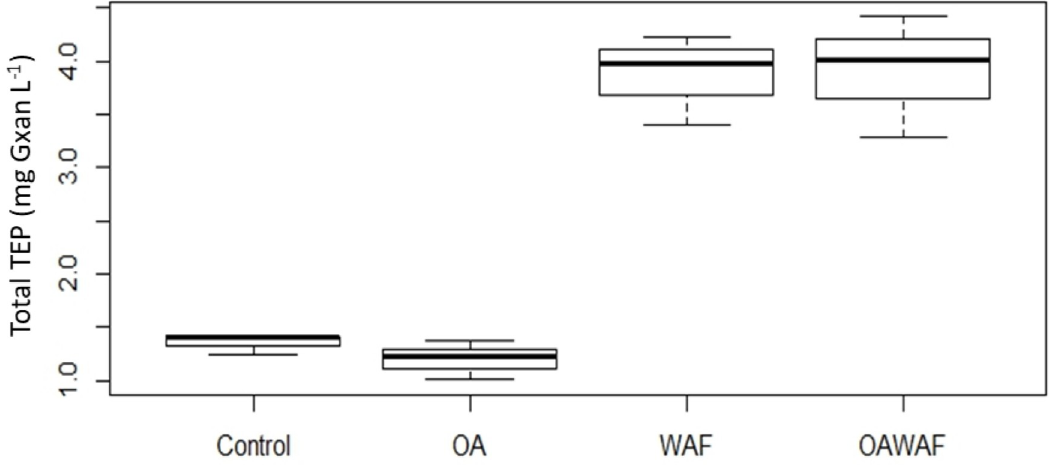
Fig 4. TEP measured at the end of the roller table experiments in the SSW only for Control, OA, WAF, and OAWAF. DCEWAF and OADCEWAF could not be measured (see Methods for technical details). Box and whisker plots with mean values (dark bar) and error bars of the maximum and minimum values for replicates. Different letters indicate which treatments are significantly ( p < 0.05) different from each other.